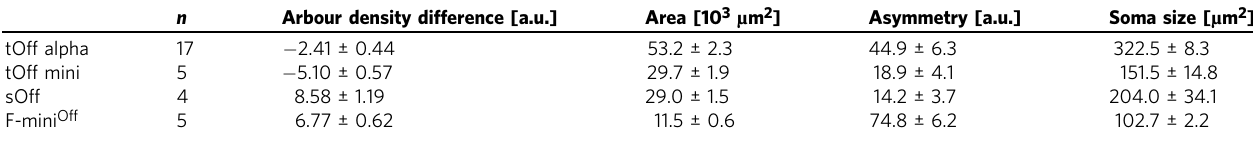
For parameter de fi nitions, see